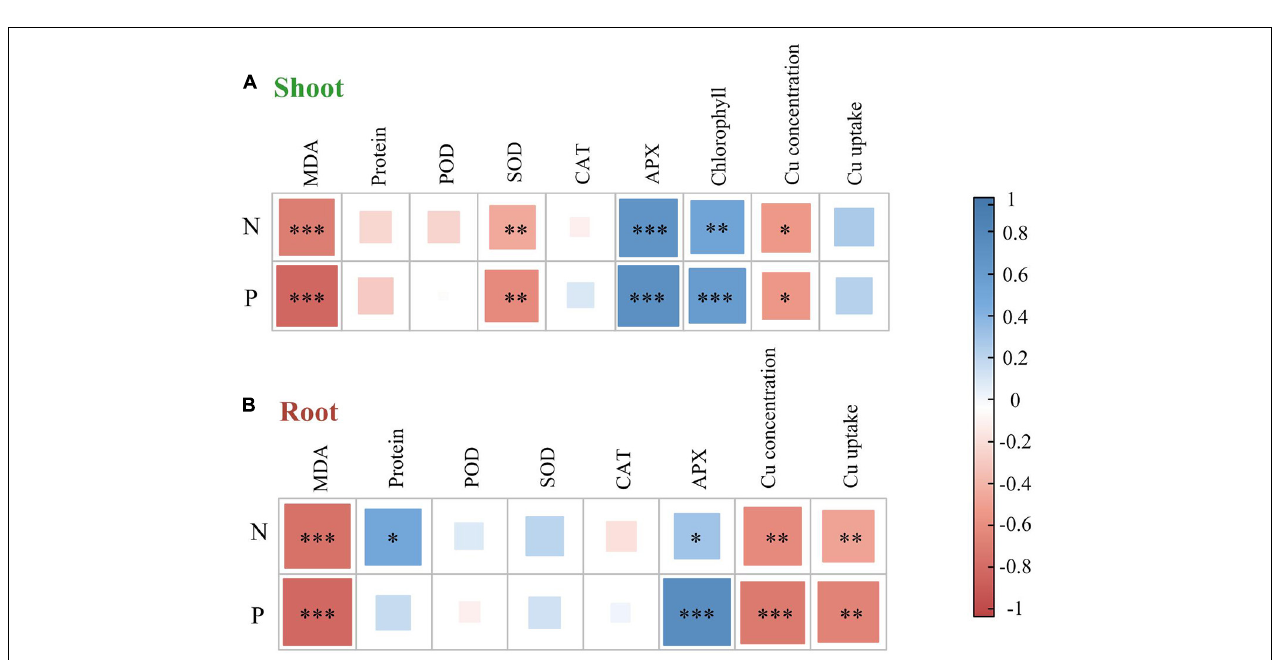
FIGURE 2 | The effect of inoculation with S. meliloti on MDA (A) and soluble protein (B) in shoot (top panel) and root (lower panel) of alfalfa with different Cu concentration treatments. MDA: malondialdehyde. The capitalized (Cu) and lowercase ( S. meliloti ) letters above the bars indicate significant difference between different Cu concentrations ( P < 0.05). The asterisks indicate significant differences between non-inoculated and inoculated alfalfa under the same Cu concentration condition. Each value represents the mean ± SE ( n = 3). *** P < 0.001; ** P < 0.01; * P < 0.05.